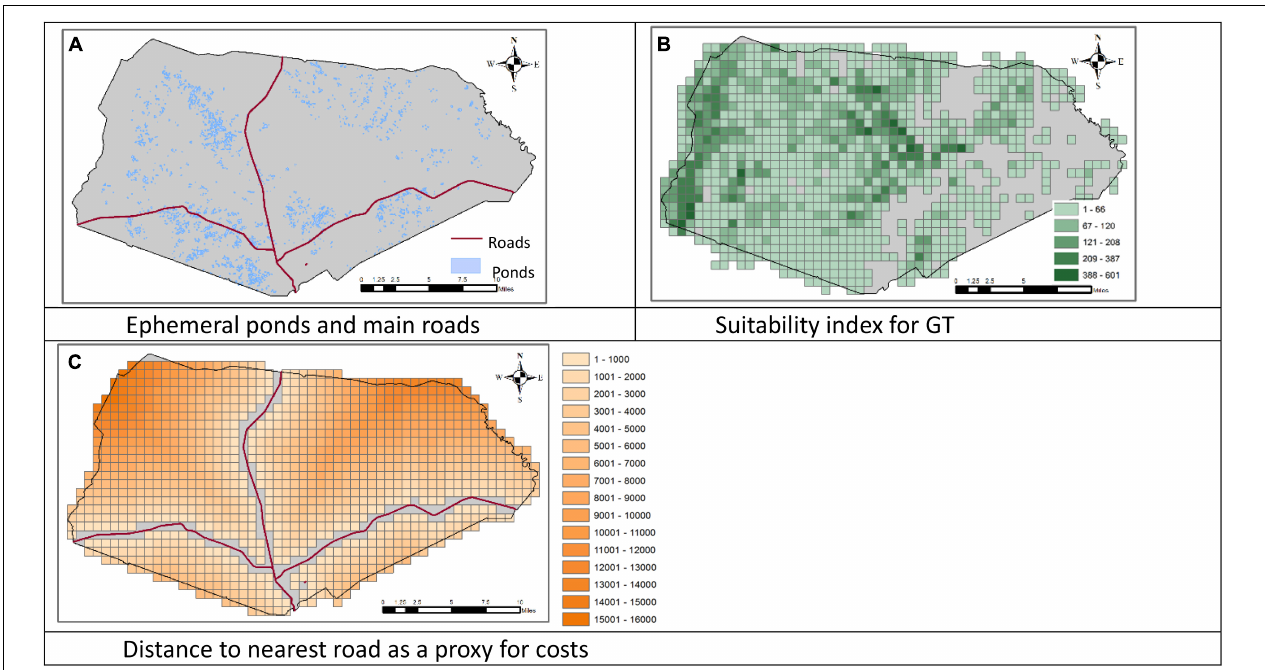
FIGURE 1 | Locations of the ephemeral ponds and roads, the suitability of the land to support the Gopher Tortoise (GT), and the distance to nearest road in the Fort Stewart military installation in Georgia, United States. (A) Ephemeral ponds and main roads. (B) Suitability index for GT. (C) Distance to nearest road as a proxy for